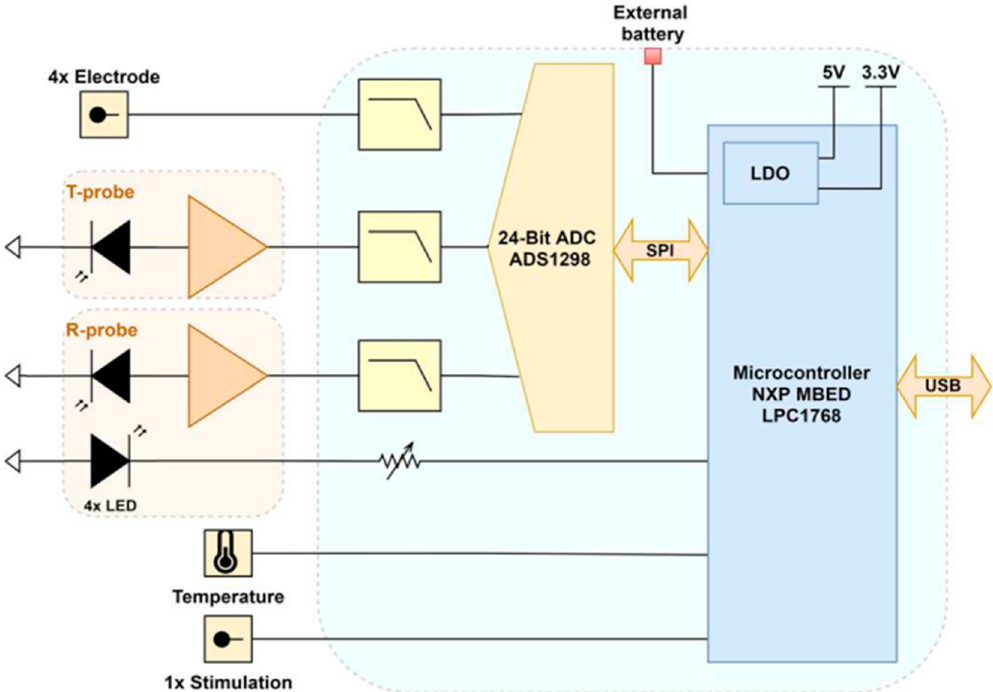
Figure 1. Block diagram of the multimodal device, with various probes on the left and the acquisition board on the right (SPI: Serial Peripheral Interface; ADC: Analog to Digital Convertor; LDO: Low DropOut).